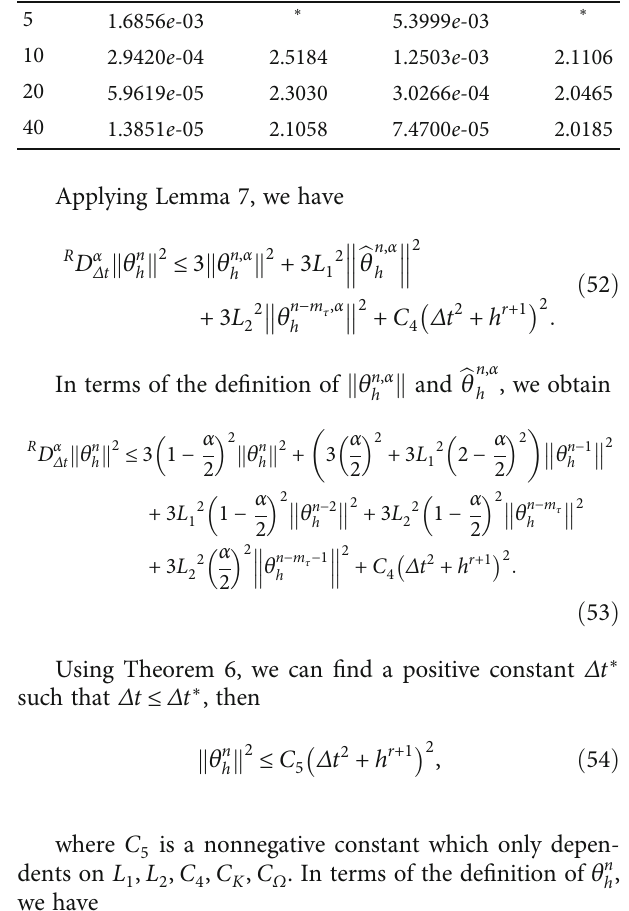
Table 1: The errors and convergence orders in temporal direction by using Q-FEM. α = 0 : 4 M Errors Orders